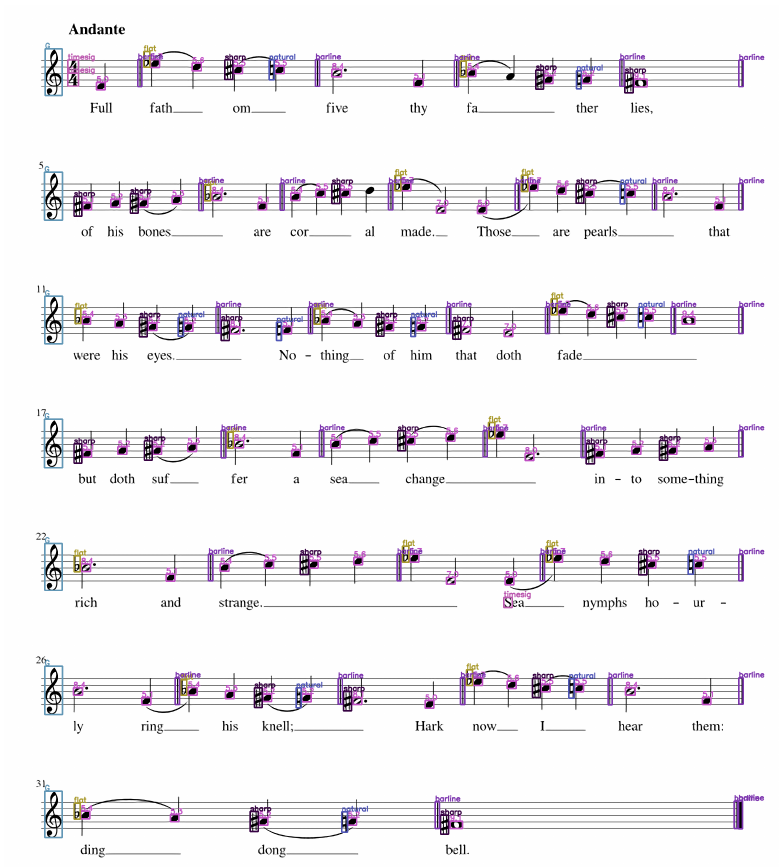
Figure 8. Detection results sample: